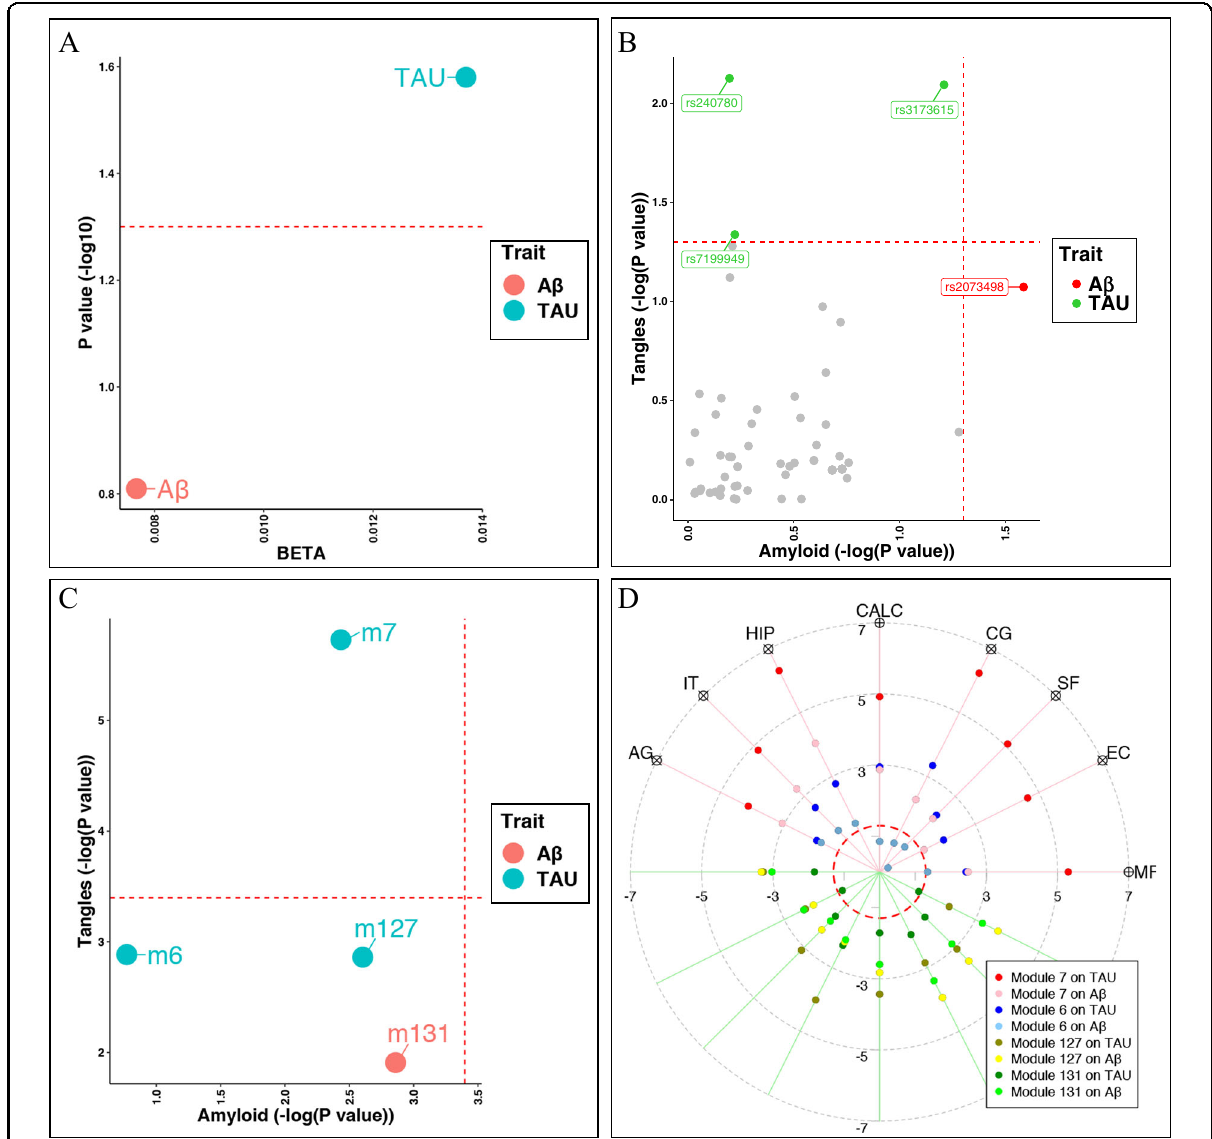
Fig. 2 Neuroticism and cognitive decline associated co-expressed gene modules are more related to TAU than A β . A Effect of neuroticism on the average levels of brain TAU and A β , which were de fi ned as the mean of the measurements across eight different brain regions of midfrontal cortex (MF), entorhinal cortex (EC), superior frontal cortex (SF), anterior cingulate cortex (CG), calcarine cortex (CALC), hippocampus (HIP), inferior temporal cortex (IT), and angular gyrus (AG). X axis represent the BETAs and Y axis represent the − log10 transformed P values for the neuroticism score on either TAU (blue dot) or A β (red dot) after adjusting for the age at death, sex, postmortem interval, race, education, study (ROS or MAP). The horizontal red dashed line represents the threshold of P = 0.05. B Comparisons of the associations to A β vs. TAU for the neuroticism-associated SNPs reported to by Nagel 2918. Each dot represented one SNP with the P values ( − log10 transformed) for A β ( X axis) and TAU ( Y axis). Gray dots showed those SNPs with P > 0.05 for both A β and TAU. Red dots showed the SNP signi fi cantly associated with A β ( P < 0.05) but not TAU ( P > 0.05), while green dots those SNPs signi fi cantly associated with TAU ( P < 0.05) but not A β ( P > 0.05). C Comparisons of the associations to A β vs. TAU for the four modules related to both cognitive decline and neuroticism. Each dot represents one module with the P values ( − log10 transformed) reported by Mostafavi et al. 6 for A β ( X axis) and TAU ( Y axis). Red dots show those modules with smaller reported P value for A β than TAU while blue dots show those modules with smaller reported P value for TAU than A β . D Target plot shows the associations between the four cognitive decline/neuroticism related modules and measures of A β and TAU across eight different brain regions, which are displayed counter-clockwise from MF, EC, SF, CG, CALC, HIP, IT, and AG. Each dot on each axis represent the signed P value ( − log10 transformed) of the association between each module and each measures of either A β or TAU at each brain region with the color codings of: module m7 on TAU in red and A β in pink, m6 on TAU in blue and A β in skyblue, m127 on TAU in gold and A β in yellow, and m131 on TAU in darker green and A β in green. The red dashed circle represents the threshold of P = 0.05. The covariates include age at death, sex, postmortem interval, race, education, study (ROS or MAP), RIN and RNA experimental batch. A β β -amyloid, TAU abnormally phosphorylated Tau protein,